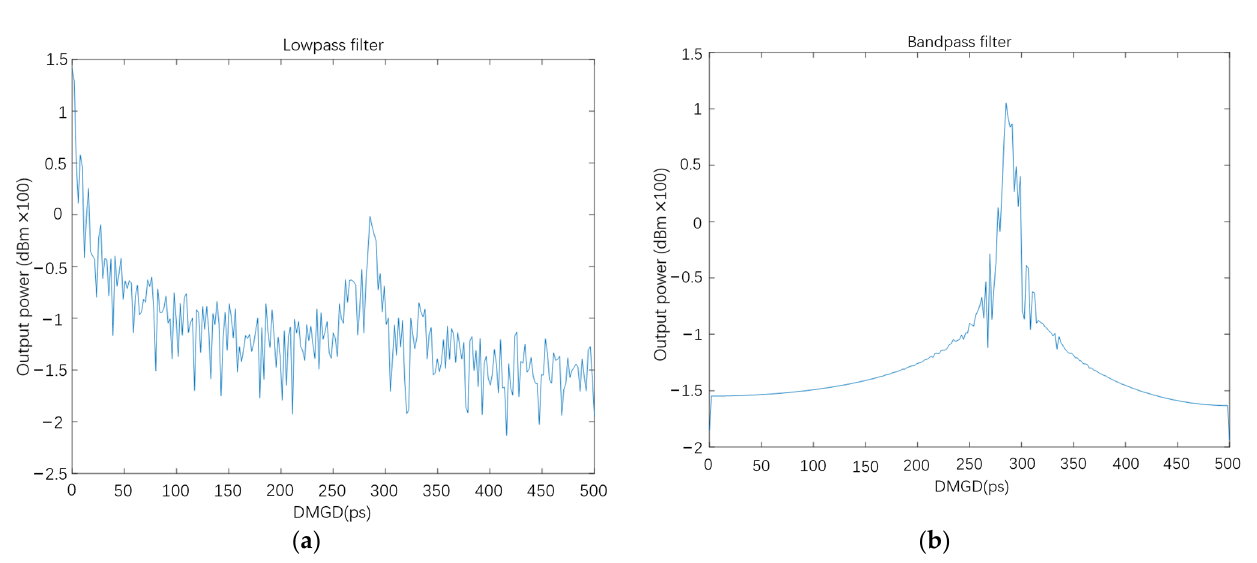
Figure 9. ( a ) The extracted FM; ( b ) the extracted HOM.